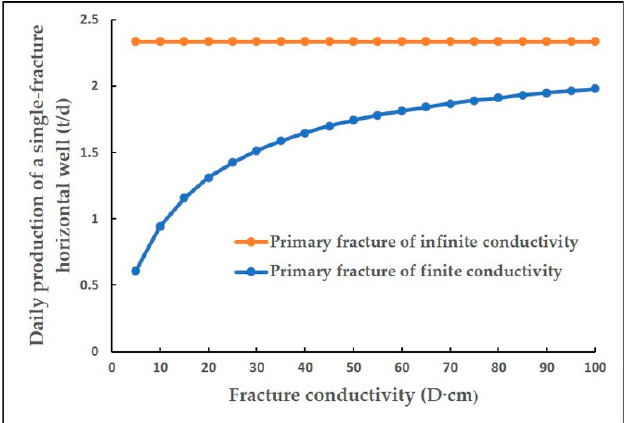
Figure 8. The influence of fracture conductivity on single-fracture horizontal well production.